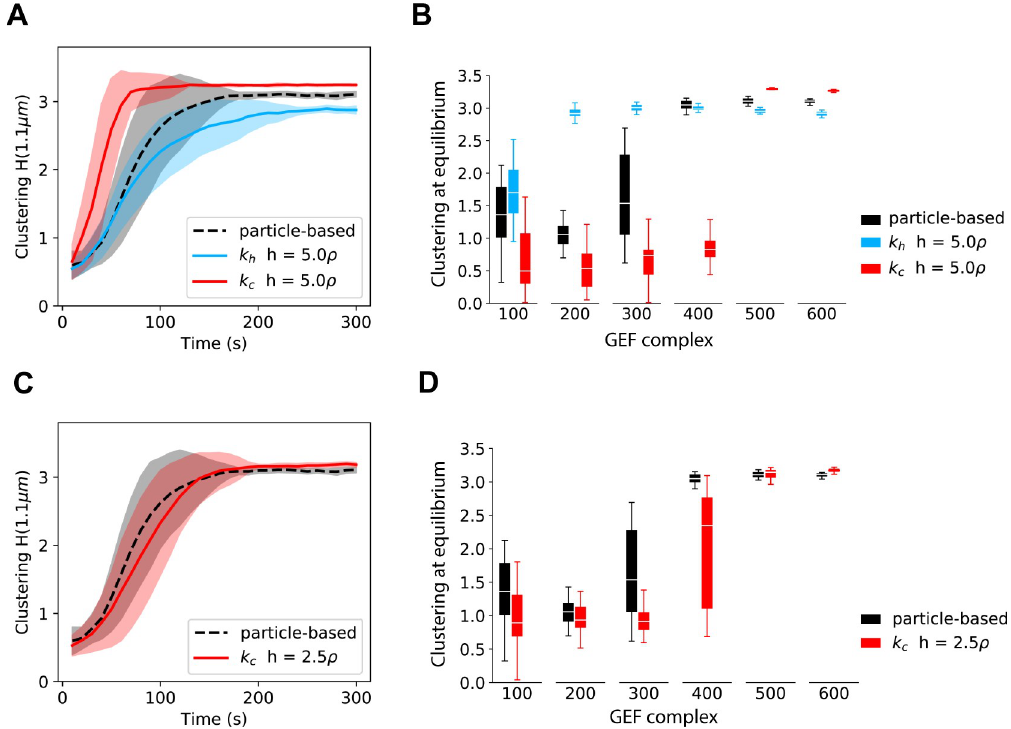
Fig 4. k and k are benchmarked against particle-based simulations by looking at polarization dynamics and h c equilibrium. (A) Time evolution of the clustering of total active Cdc42 from simulations of the polarity model in Fig 3A with parameters in Table 1. We contrast results from particle-based simulations and the spatial Gillespie approach using either k h or k c and a grid element size h = 5 ρ . Clustering at a particular timepoint is quantified as the mean of H( r = 1.1 μ m) over 30 simulations. Uncertainty intervals are computed as mean ± standard deviation and presented as a shaded region enveloping the mean. (B) Clustering at equilibrium from simulations in (A) for different values of the total amount of GEF. The clustering at equilibrium is computed as the mean of H( r = 1.1 μ m) between 250s and 300s. The box plots were generated with the clustering at equilibrium from 30 simulations. (C) and (D) are corresponding figures to (A) and (B) respectively, the only difference is that the spatial Gillespie simulations are run with h = 2.5 ρ and using only k c as k h cannot be computed for such h in this model (see